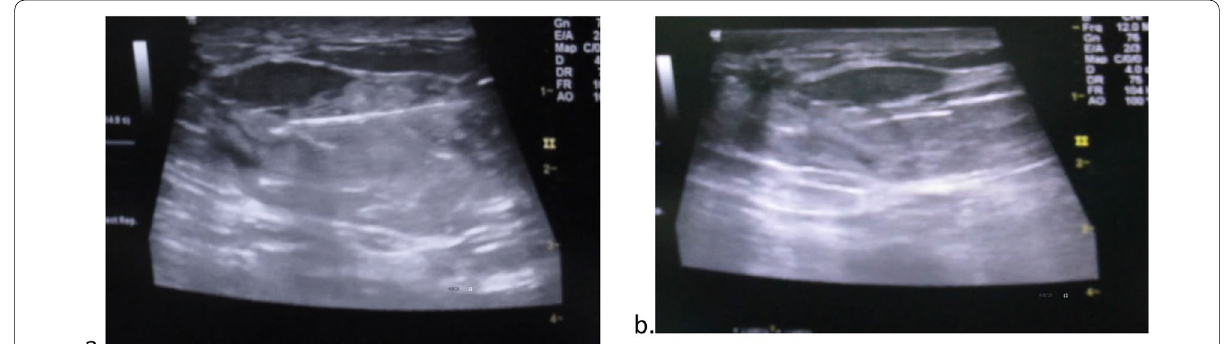
Fig. 1 a , b Local anesthetic injection around the lesion and along course of